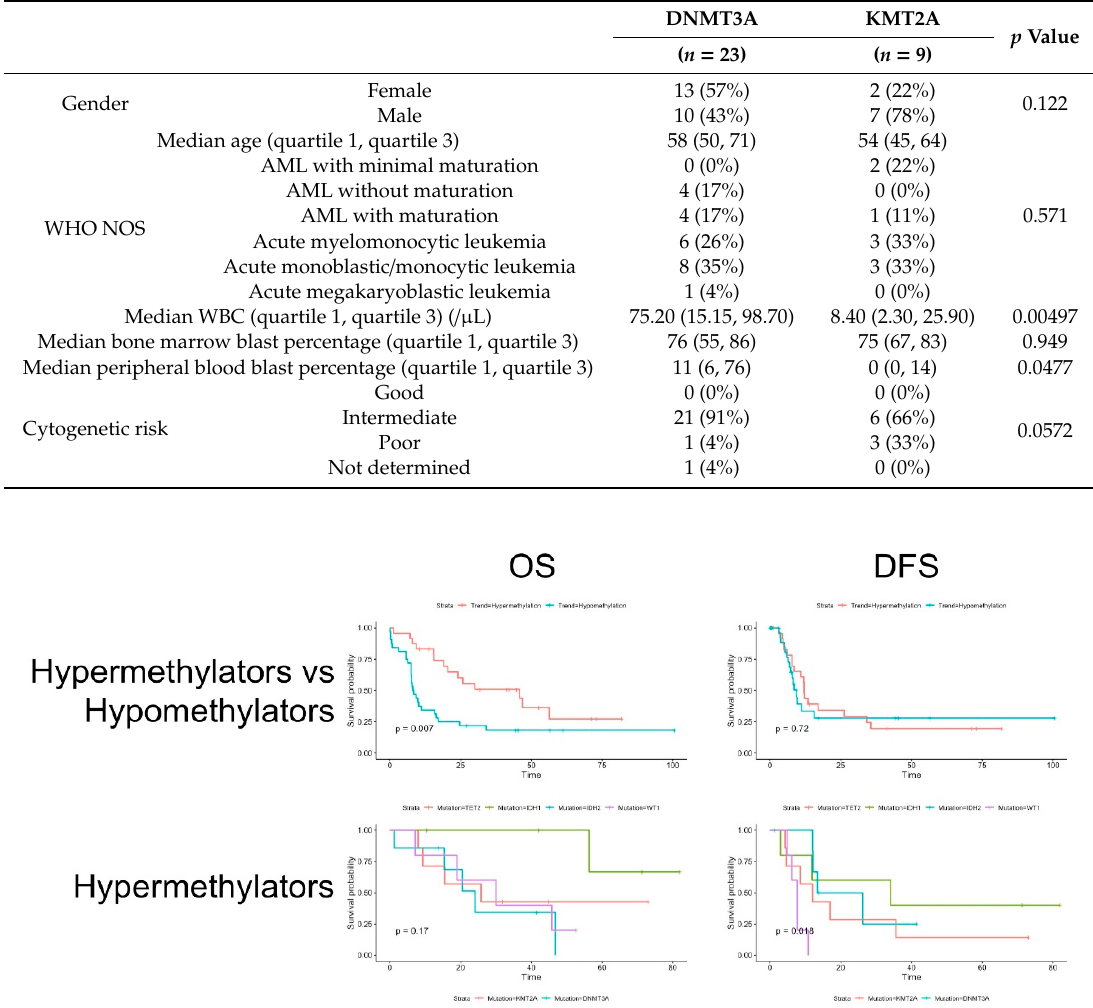
Table 3. Clinical di ff erences between the hypomethylating mutations.